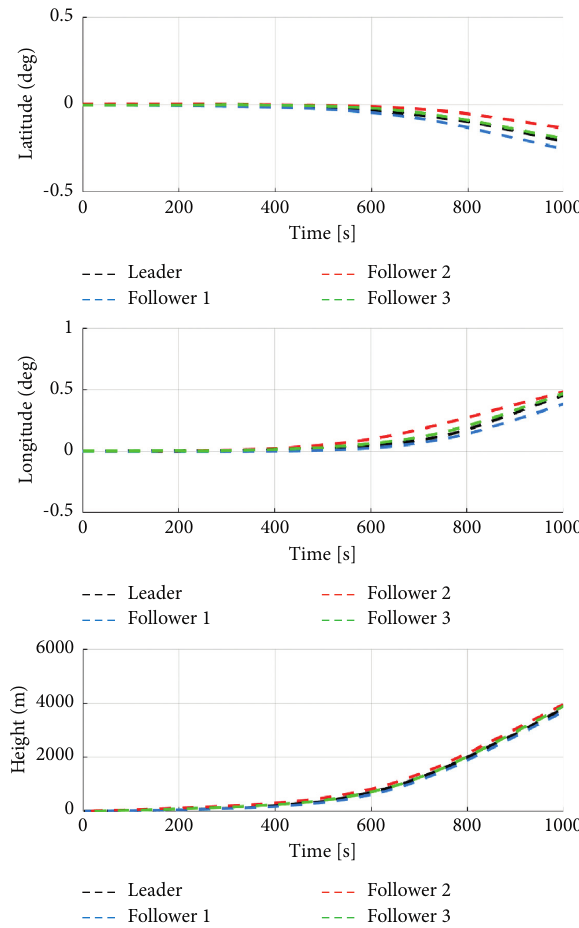
Figure 8: Position curves of the strap-down inertial navigation